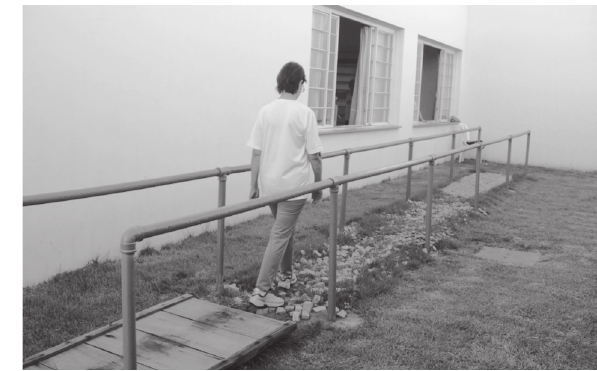
Figura 1 - Posições distintas dos pés analisadas em Romberg Figura 2 - Idosa durante marcha na pista de